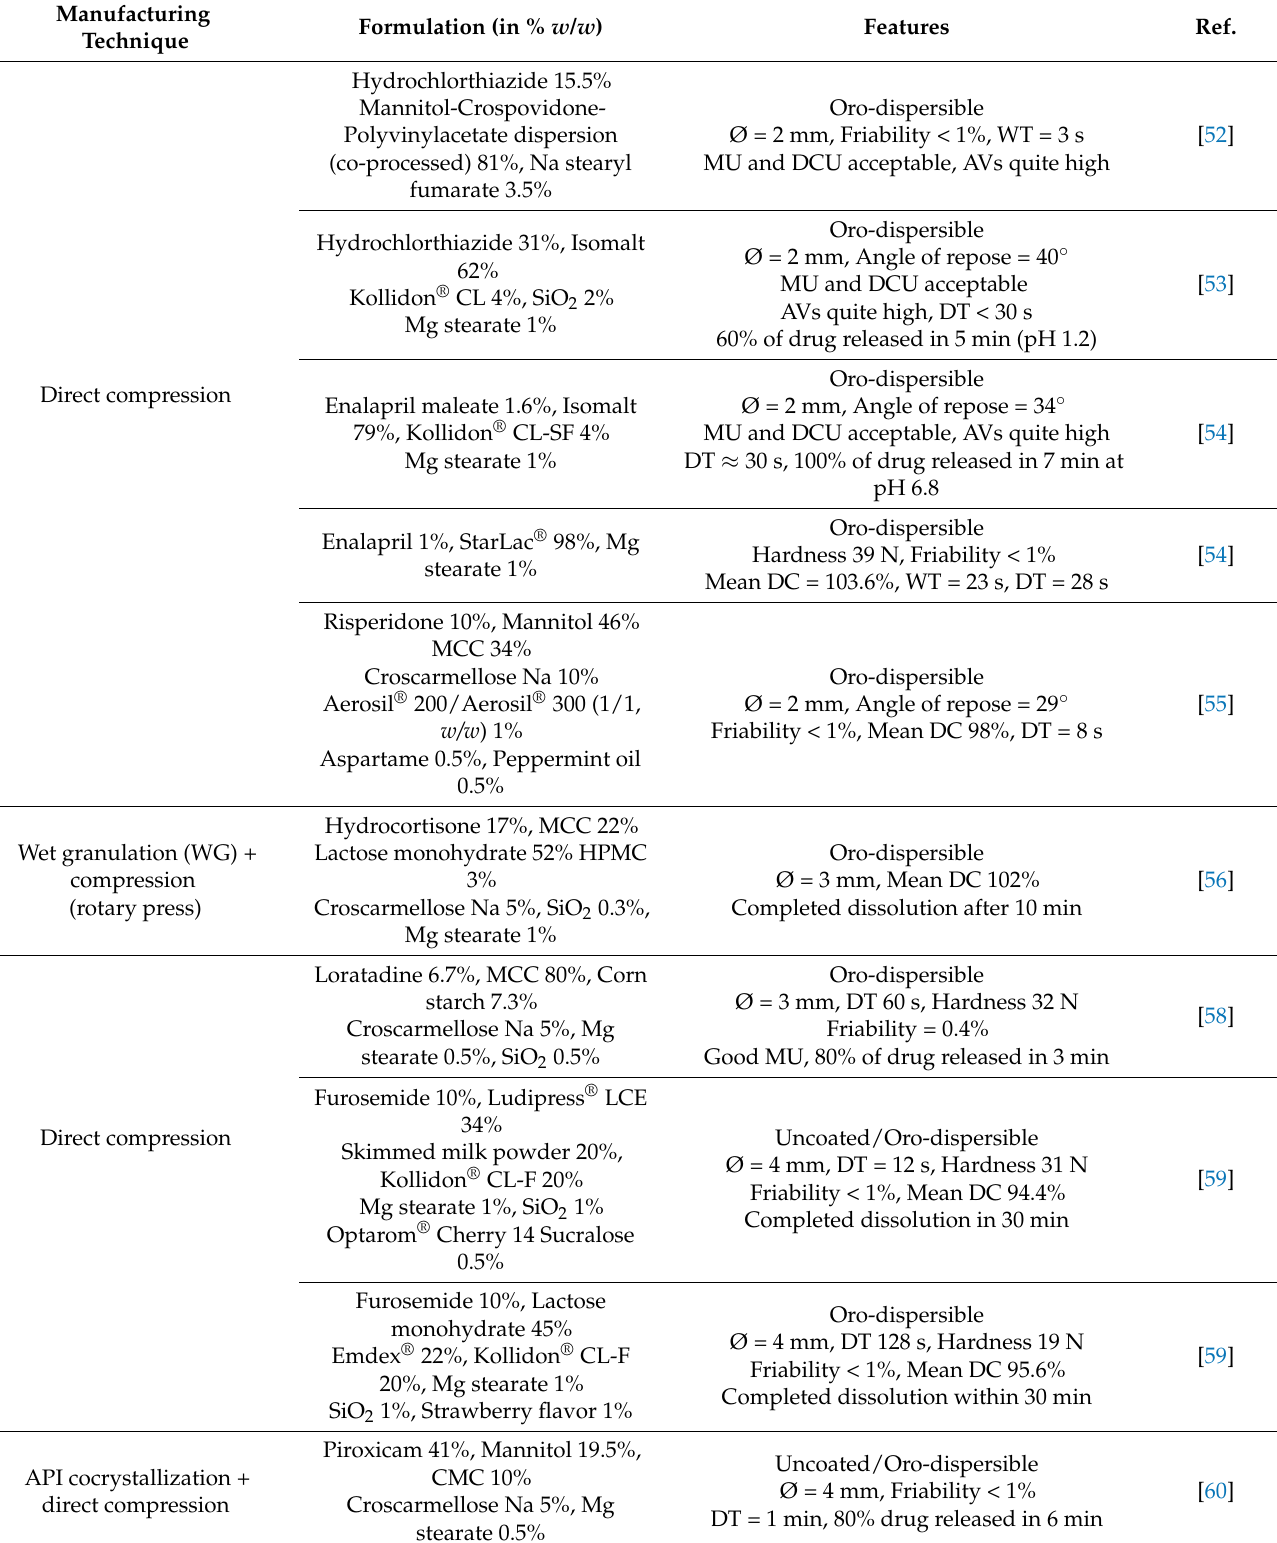
Table 5. Mini-tablets (MTs) and micro-tablets (MicroTs) formulations and their distinctive